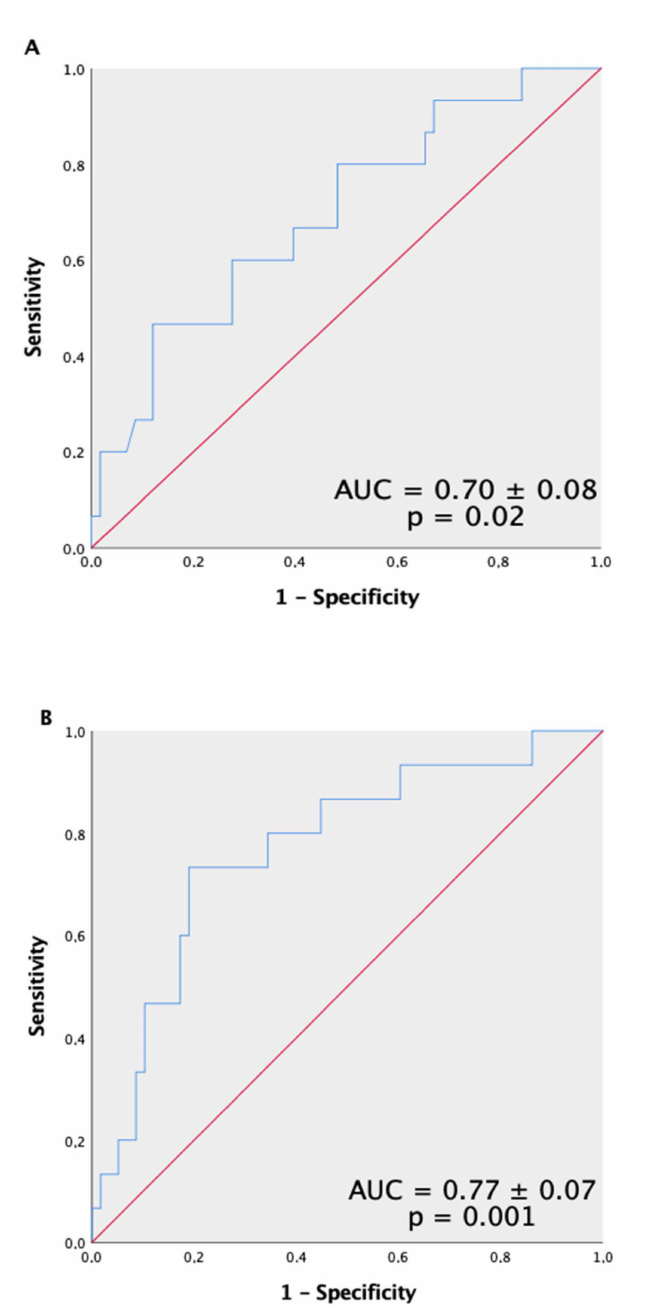
Figure 2. Receiver operating characteristic (ROC) curve of circulating RANGAP1 for the detection of cardiac allograft rejection. Ability of RANGAP1 to detect significant ACR (grades 2R–3R) ( A ). The two independent predictive blood parameters indicative of significant ACR: RANGAP1 and log NT-proBNP combined ( B